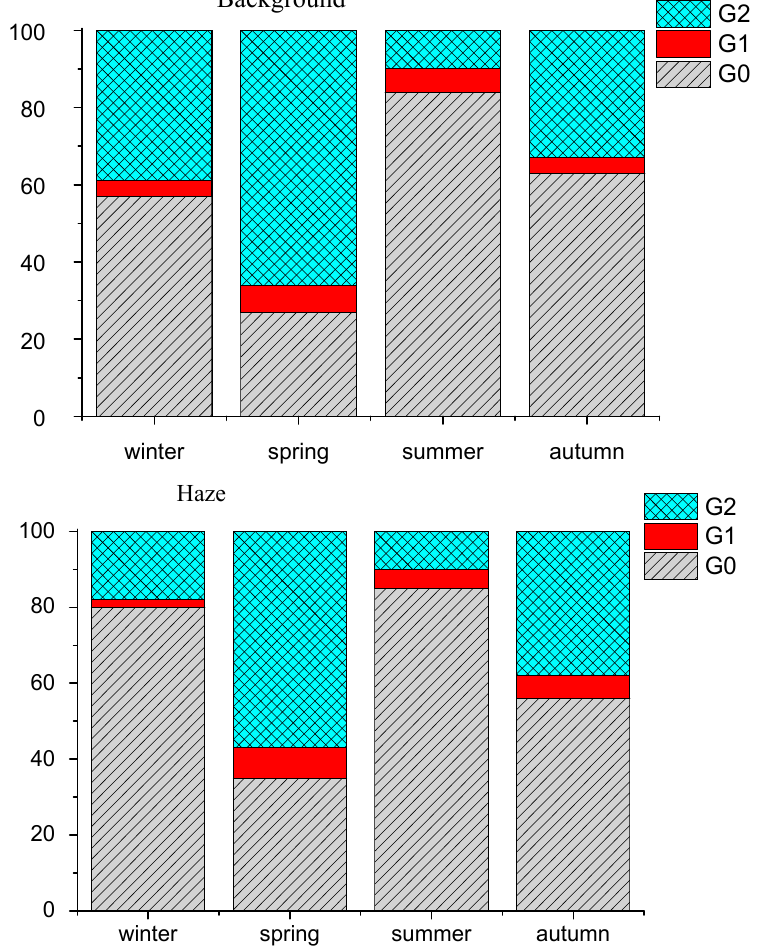
Figure 5. Frequencies of occurrence of di ff erent types of hygrograms in types of aerosol weather “Background” and “Haze-S”.